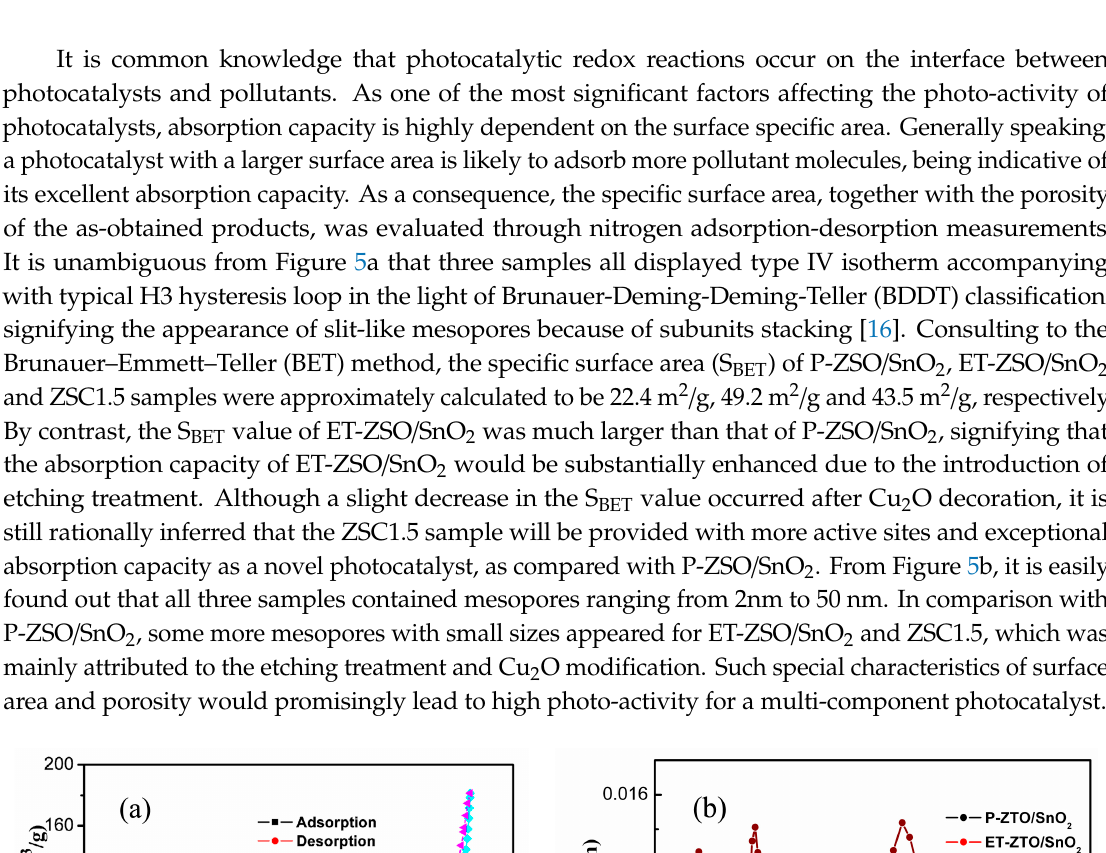
Figure 5. ( a ) The Nitrogen adsorption–desorption isotherm and ( b ) the corresponding pore size and distribution of P-ZSO/SnO 2 , ET-ZSO/SnO 2 and ZSC1.5 samples.